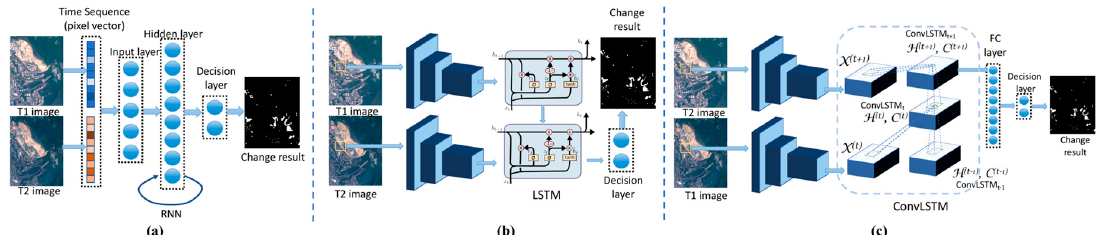
Figure 17. Schematic diagram of structures based on the sequential network. ( a ) recurrence neural network (RNN) based on pixel vectors; ( b ) long short-term memory (LSTM) network with CNN; ( c ) convolution LSTM network with CNN.